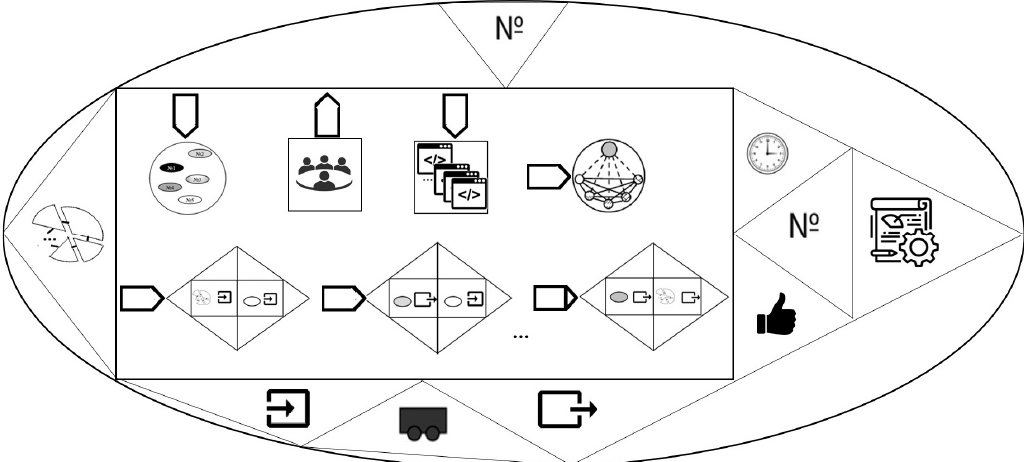
Figure 2. The subject-figurative model of the Cognitive hybrid intelligent diagnostic system.